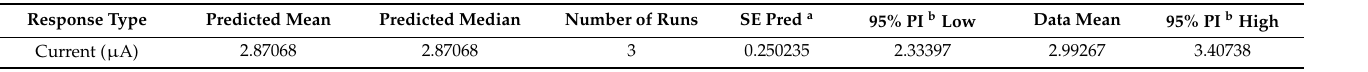
Table 4. Model confirmation results.